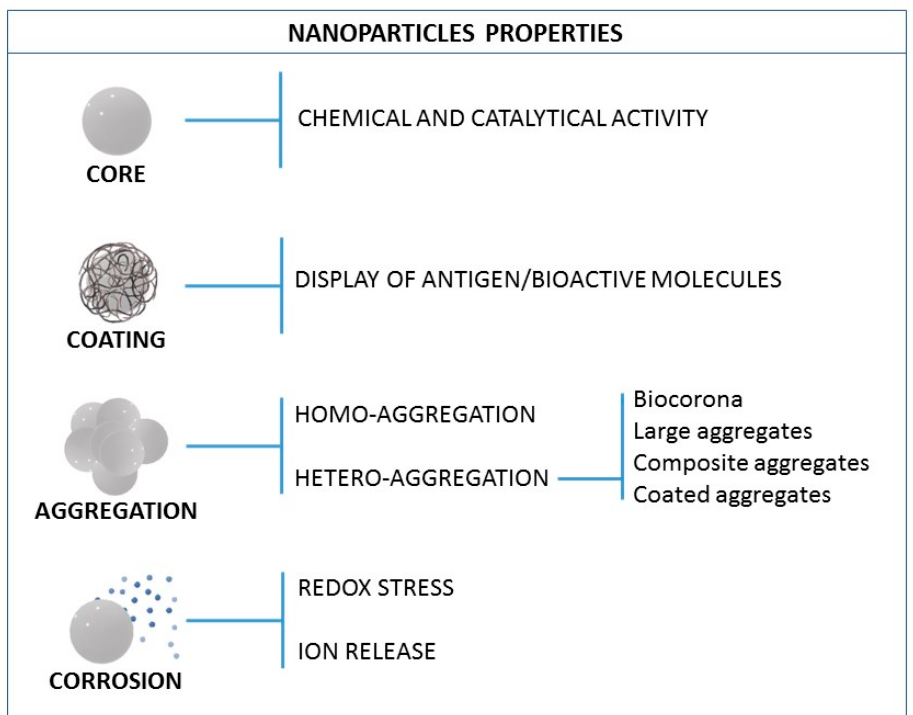
Figure 4. The NP properties that can impact the immune system.